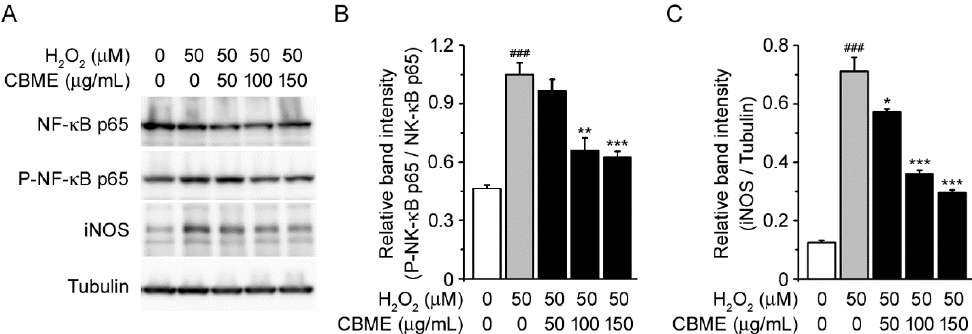
Figure 6. Effects of Chrysanthemum boreale Makino extract (CBME) on NF-κB phosphorylation and iNOS in SH-SY5Y cells exposed to H 2 O 2 . ( A ) Western blot bands corresponding to NF-κB, P- NF-κB, and iNOS in SH-SY5Y cells, which were pre-treated with the indicated concentrations of CBME for 3 h and then exposed to H 2 O 2 for 24 h. Tubulin was used as the loading control. ( B ) Relative band intensity of P-NF-κB was quantified using densitometric analysis and then normalized to that of NF-κB. ( C ) Relative band intensity of iNOS was quantified using densitometric analysis and then normalized to that of tubulin. Values in the bar graphs are the mean ± SEM of at least three inde- pendent experiments. *** p < 0.005, ** p < 0.01, * p < 0.05, significantly different from the H 2 O 2 group. ### p < 0.005, significantly different from the control group.